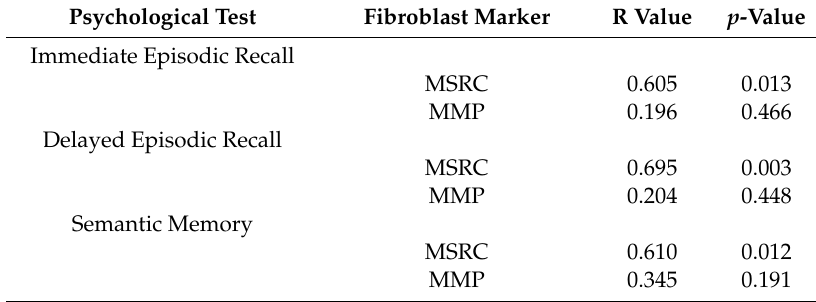
Table 3. Neuropsychological fibroblast metabolism correlations corrected for age, years of education and grey matter reserve.